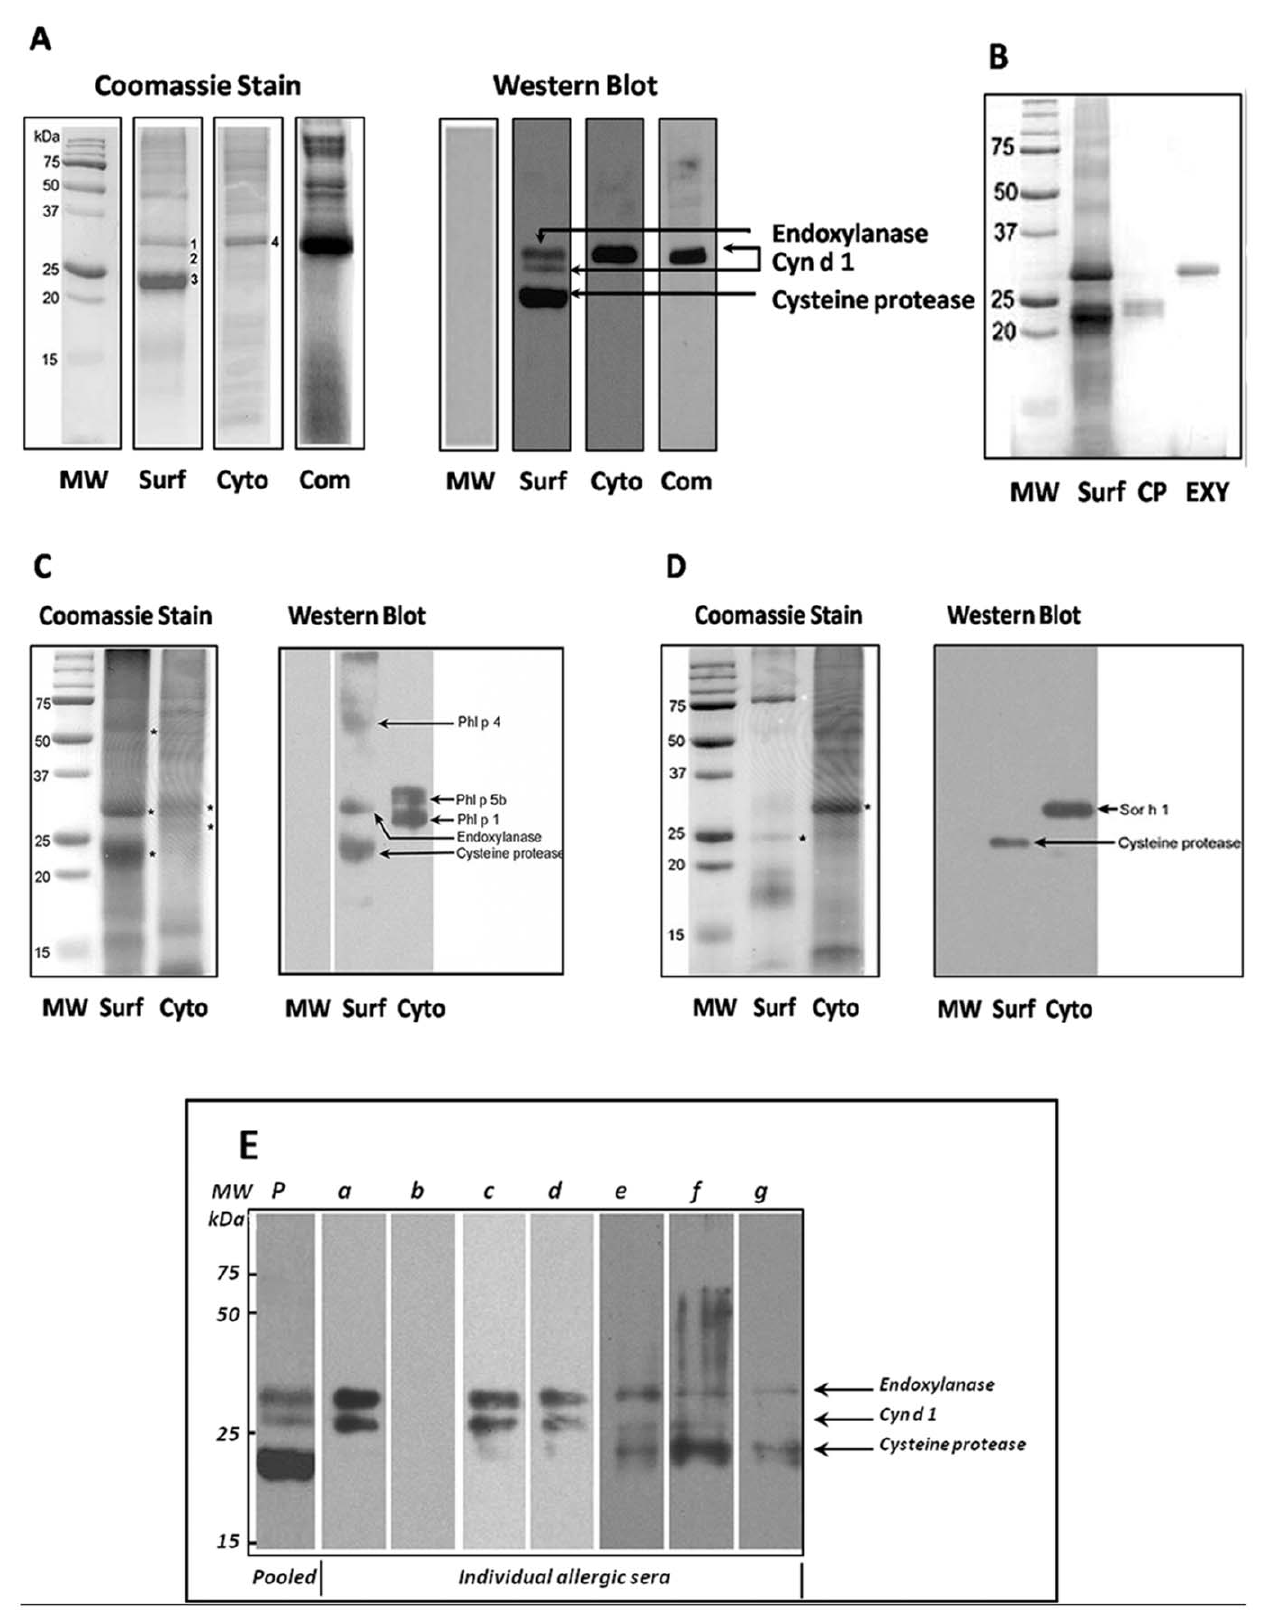
Figure 2. SDS-PAGE and immunoblotting analyses of in-lab preparations of pollen surface (coat), cytoplasmic proteins and commercial defatted pollen from Bermuda grass, Timothy grass, and Johnson grass. Raw un-defatted pollens were extracted with